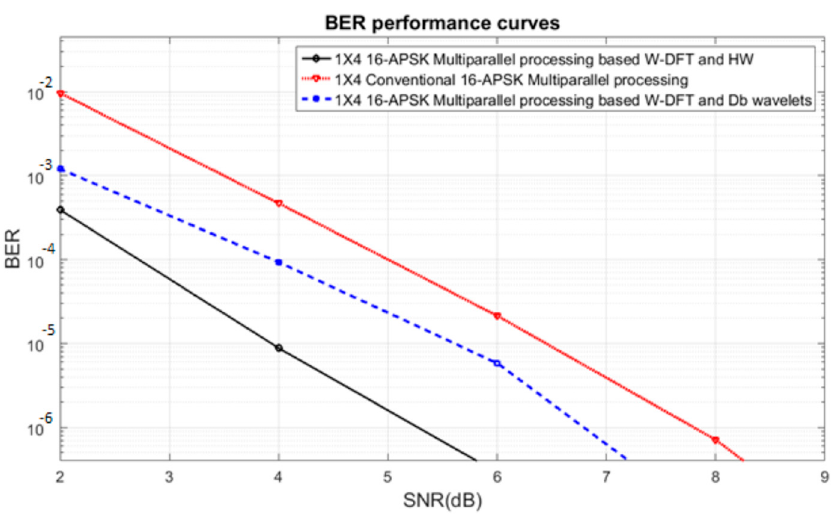
Figure 10. The comparison results based on BER curves.